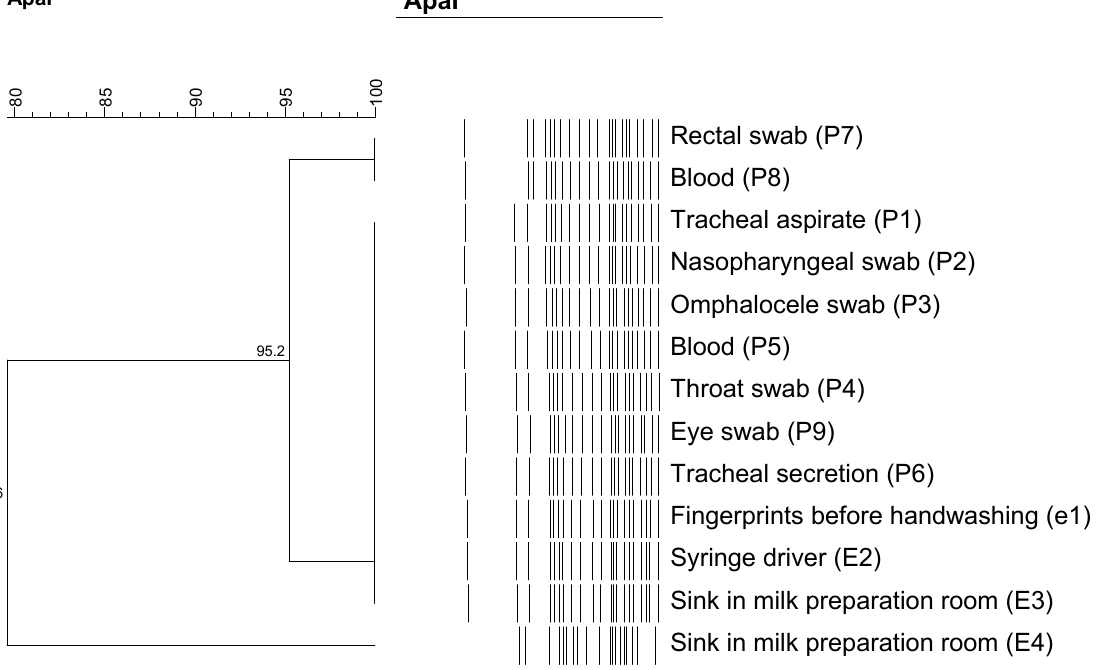
Figure 3. Dendrogram plot: result of molecular typing of CRAB from different sources and their percentage of similarity.